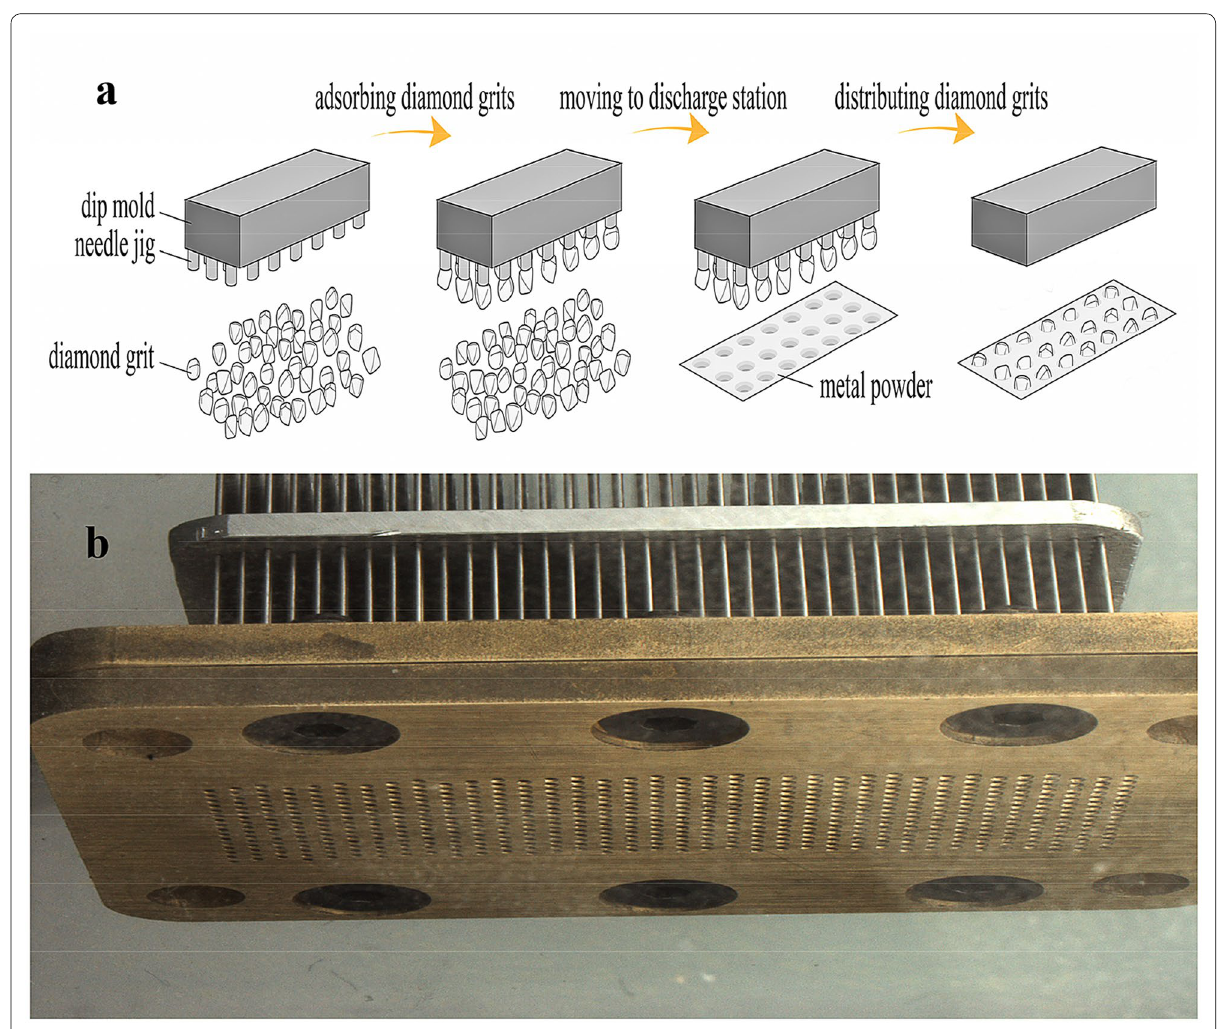
Figure 2 a Schematic of orderly arranged diamond grits using a needle jig; b Needle jig with inner